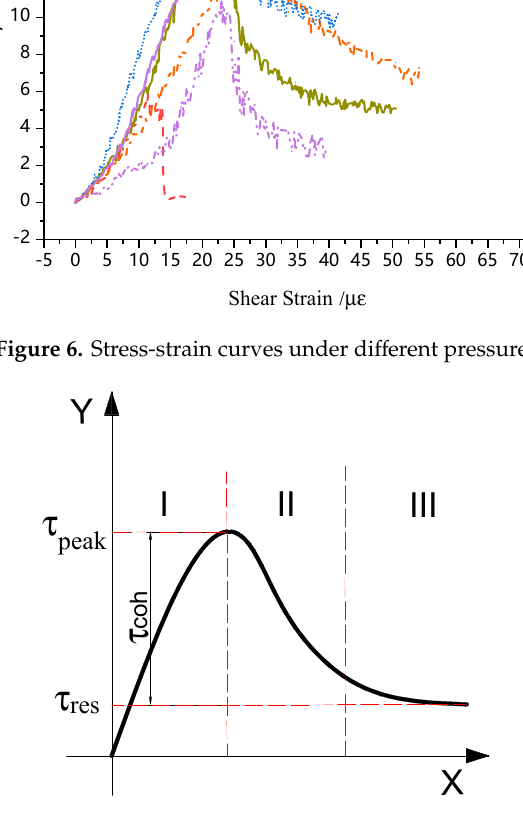
Figure 7. Division of stress-shear stress-strain curves at di ff erent stages.